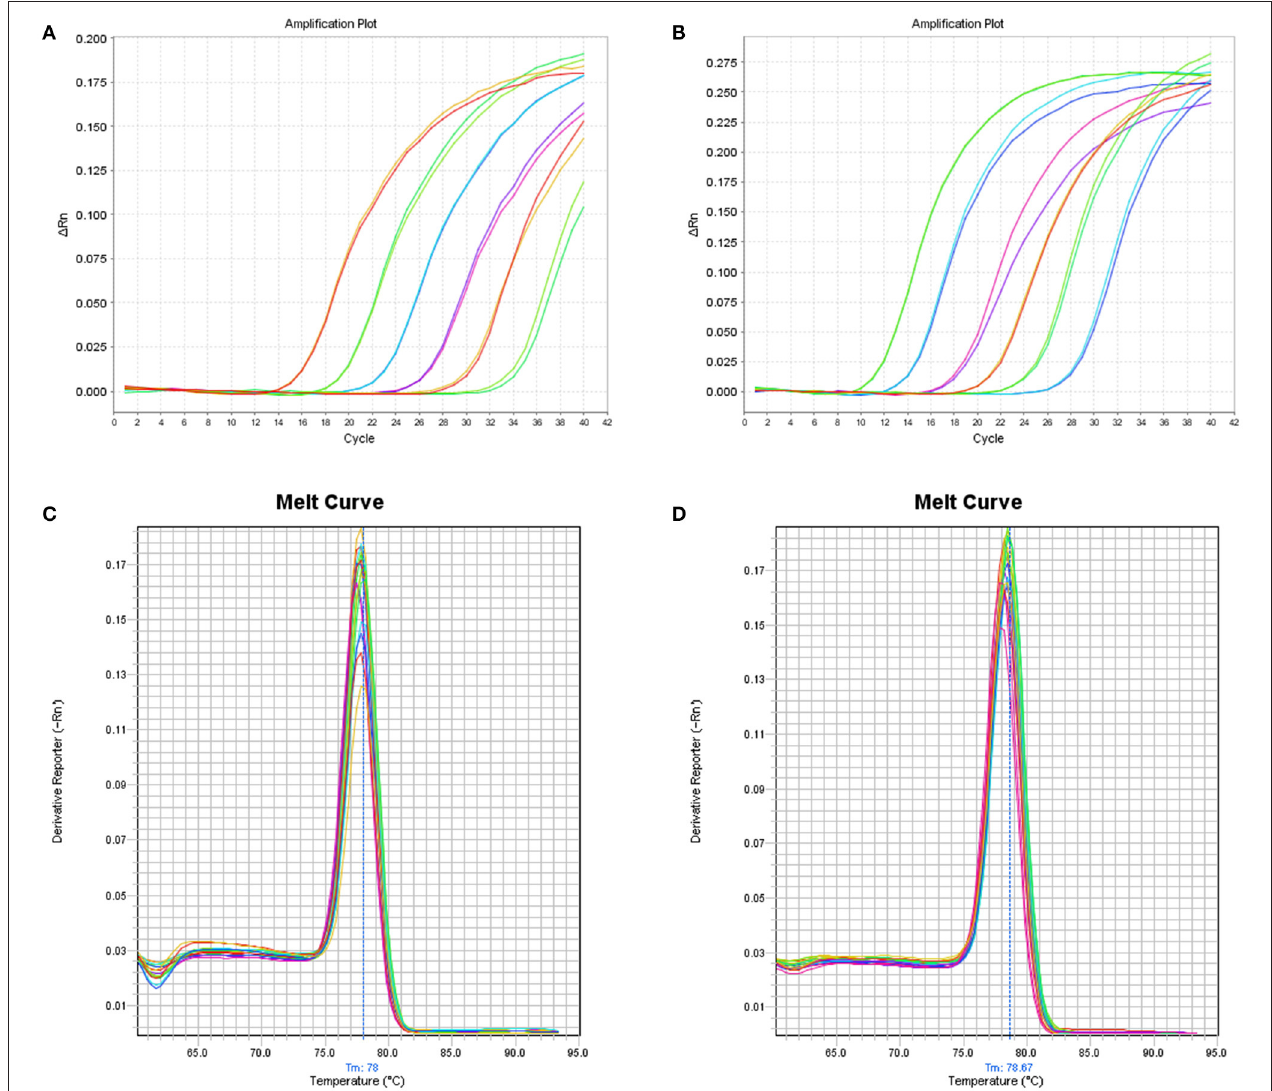
FIGURE 1 | (A) Linear amplification curves of the SYBR Green-based qPCR assay using six duplicated 10-fold serial dilutions (10 6 -10 1 copies/ µ L) of the BPV2 plasmid template. The standard curves for BPV2 present R 2 = 0.999, slope = − 3.488, and eff = 98.2%. (B) The linear amplification curves of the SYBR